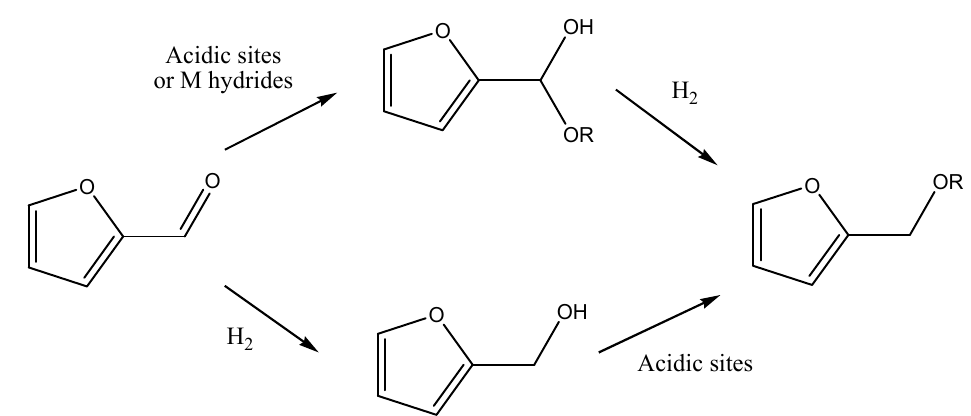
Scheme 8. Possible reaction pathway for the reductive etherification of